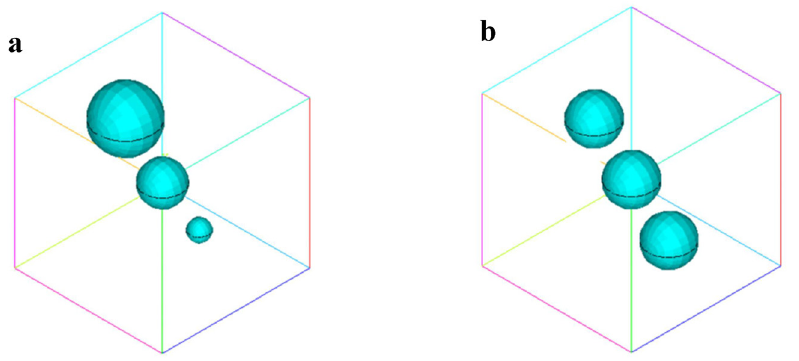
Figure 9: Sphere model of the foamed samples with di ff erent cell size distributions: ( a ) S d = 1 and ( b ) S d =